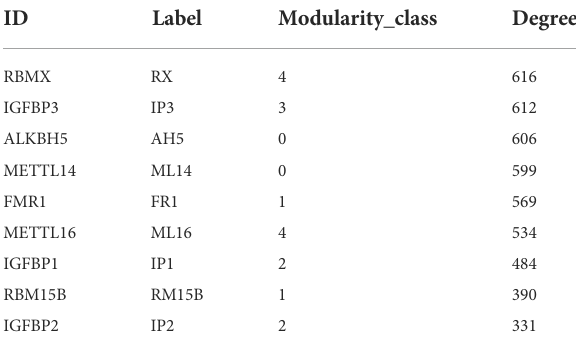
TABLE 1 Nine m6A regulators information tables in the WGCNA high correlation